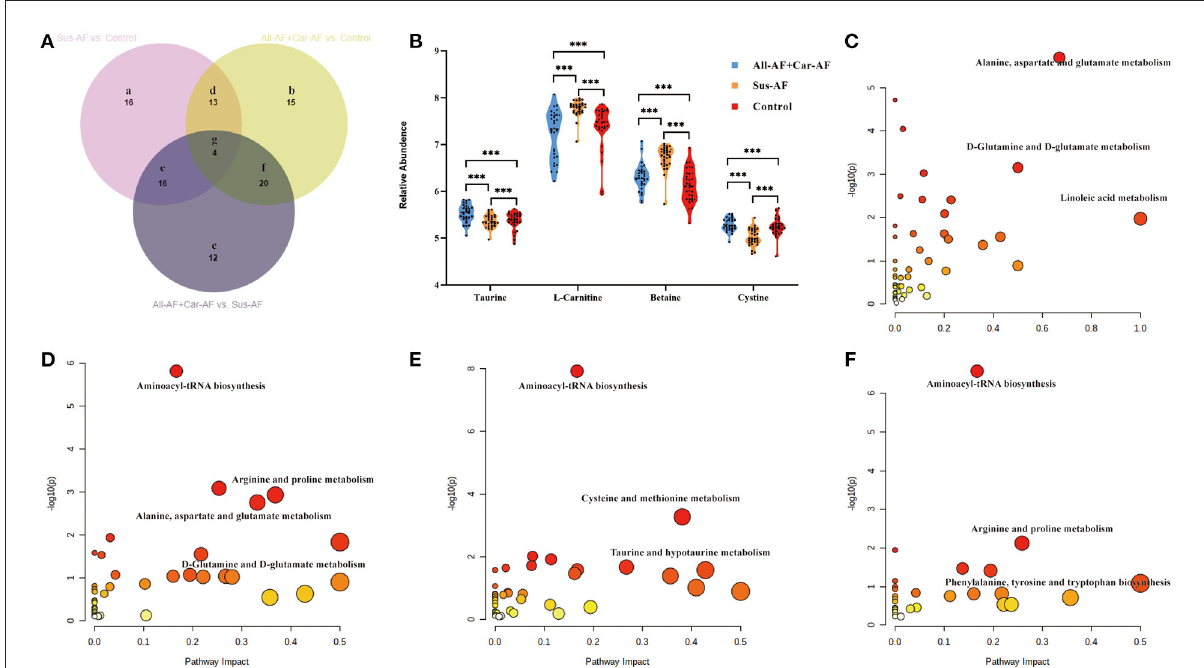
FIGURE4 Differential metabolites and pathways involved in the experimental groups. (A) Venn diagram shows discriminant metabolites can be classified into regions a, b, c, d, e, f, and g. (B) Serum taurine, L-carnitine, betaine, and cystine levels change in the three comparisons. (C) Pathway analysis of differential metabolites in Venn a + d + e + g region. (D) Pathway analysis of differential metabolites in Venn b + d + f + g region. (E) Pathway analysis of differential metabolites in Venn c + e + f + g region. (F) Pathway analysis of differential metabolites in Venn b + g. *** p <